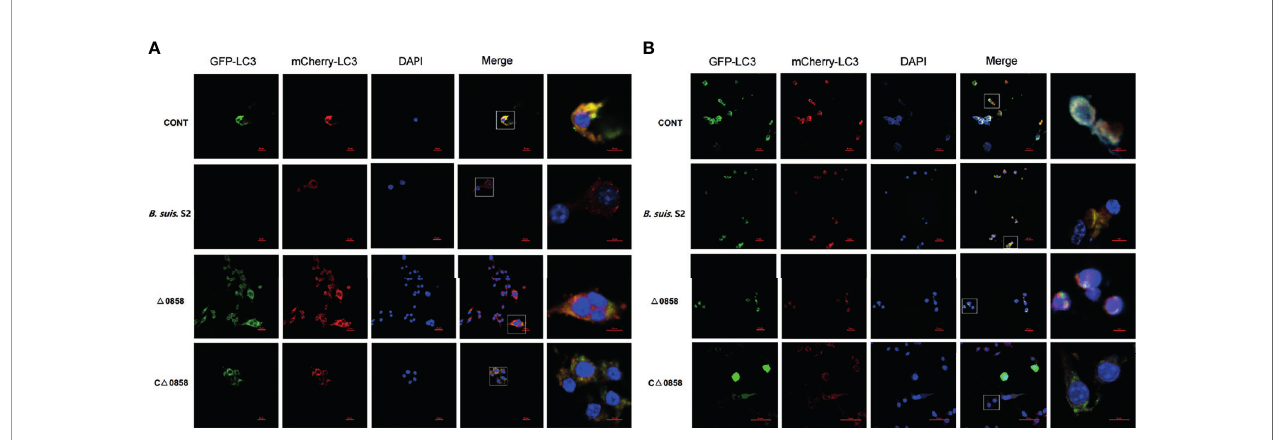
FIGURE 4 | BSS2_II0858 mutant blocked autophagy fl ux. (A) Representative confocal images of the RAW 264.7 grown on coverslips were transfected with mCherry-GFP-LC3 for 24 h, then infected with WT, BSS2_II0858 mutant, and complementation strains at 24 (A) and 48 h